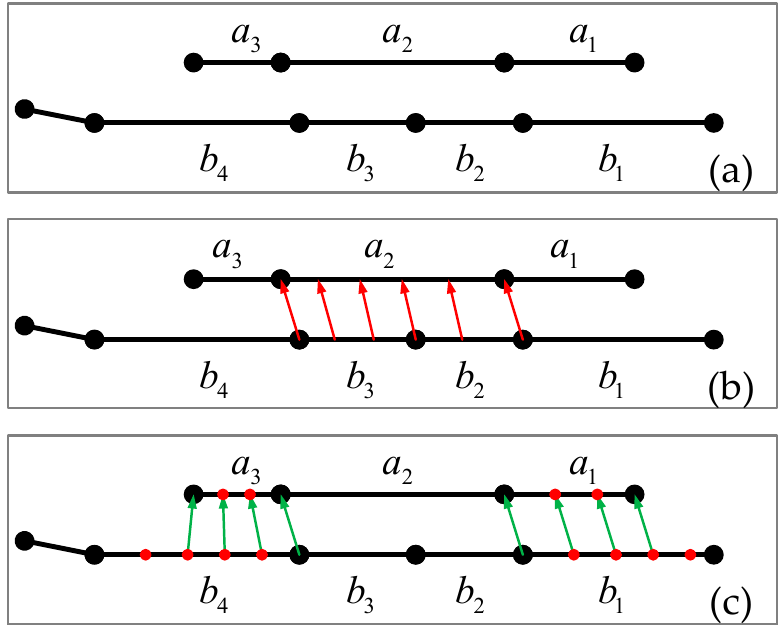
Figure 9. Complementary relationship between two partial stroke matching algorithms: ( a ) shows two initially unmatched strokes; ( b ) shows the result of the SPMA-S algorithm (red arrows represent the matching relationship); ( c ) shows the result of the SPMA-V algorithm (green arrows represent the matching relationship, and red dots are the inserted vertices according to a certain density).